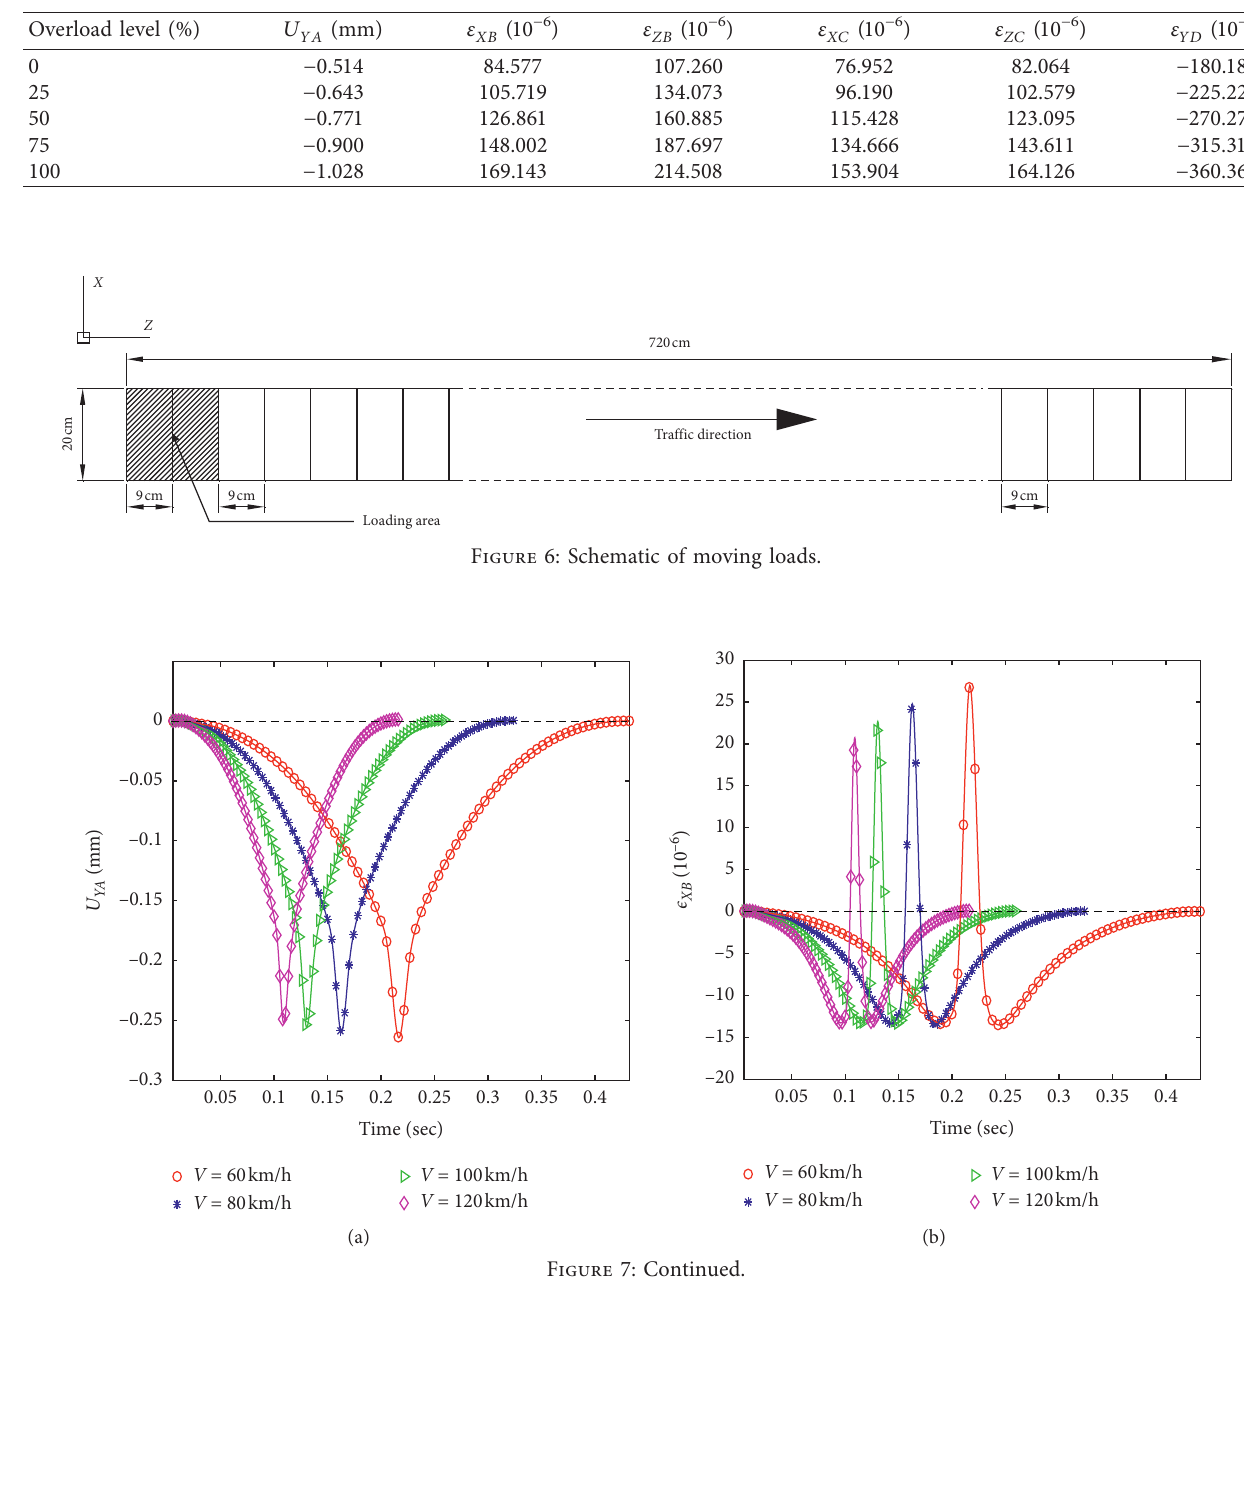
Table 6: Responses with different overload level at the higher temperature.